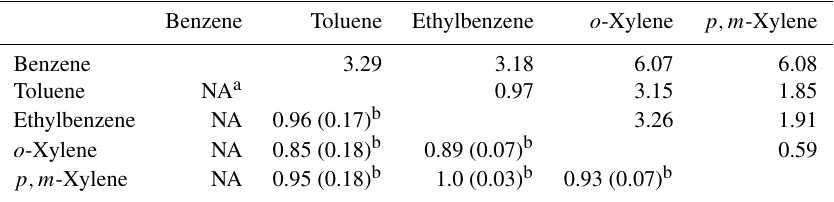
Table 12. Comparison of slopes calculated from Eq. (4) based on the assumption that different VOC have identical R [OH]d t (above diagonal) with slopes determined from linear regression of the observations (below diagonal).